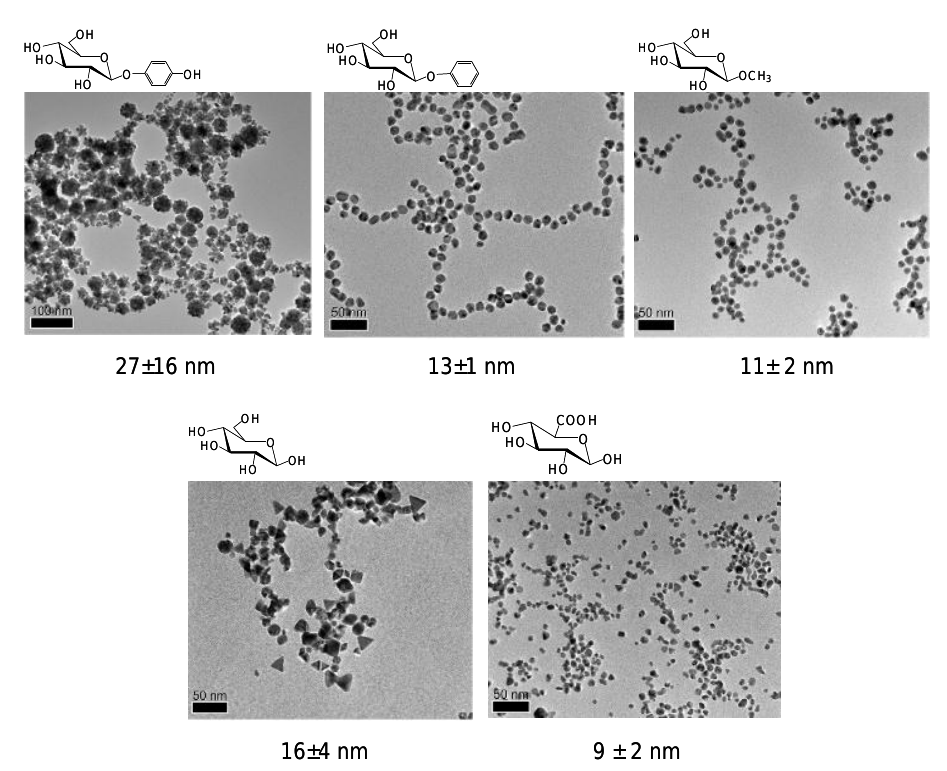
Figure 2. Characterization of the glucoside-induced AuNPs by high resolution transmission electron microscope (HRTEM).